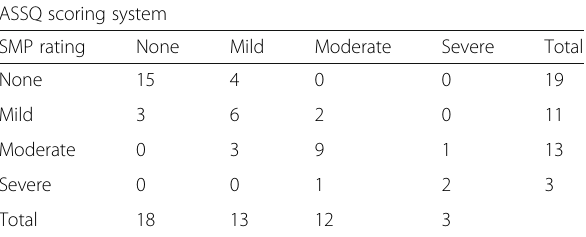
Categories of clinical sleep problem between the sleep medicine physician (rows) and the ASSQ (columns). Perfect agreement is along the